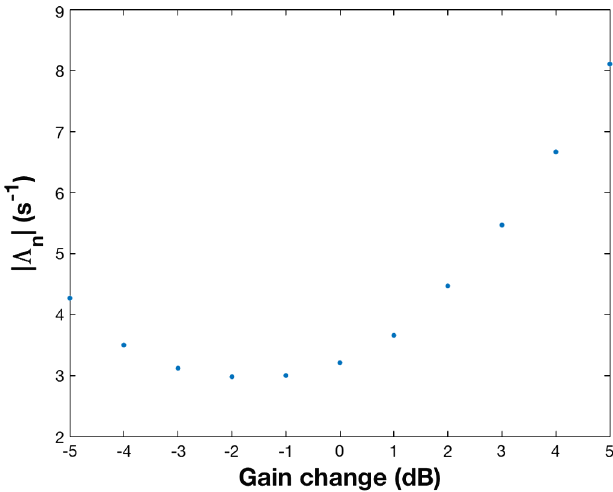
FIG. 15. Highest j Λ n j with llrf gain change. Configuration ( β ), OTFB Off.